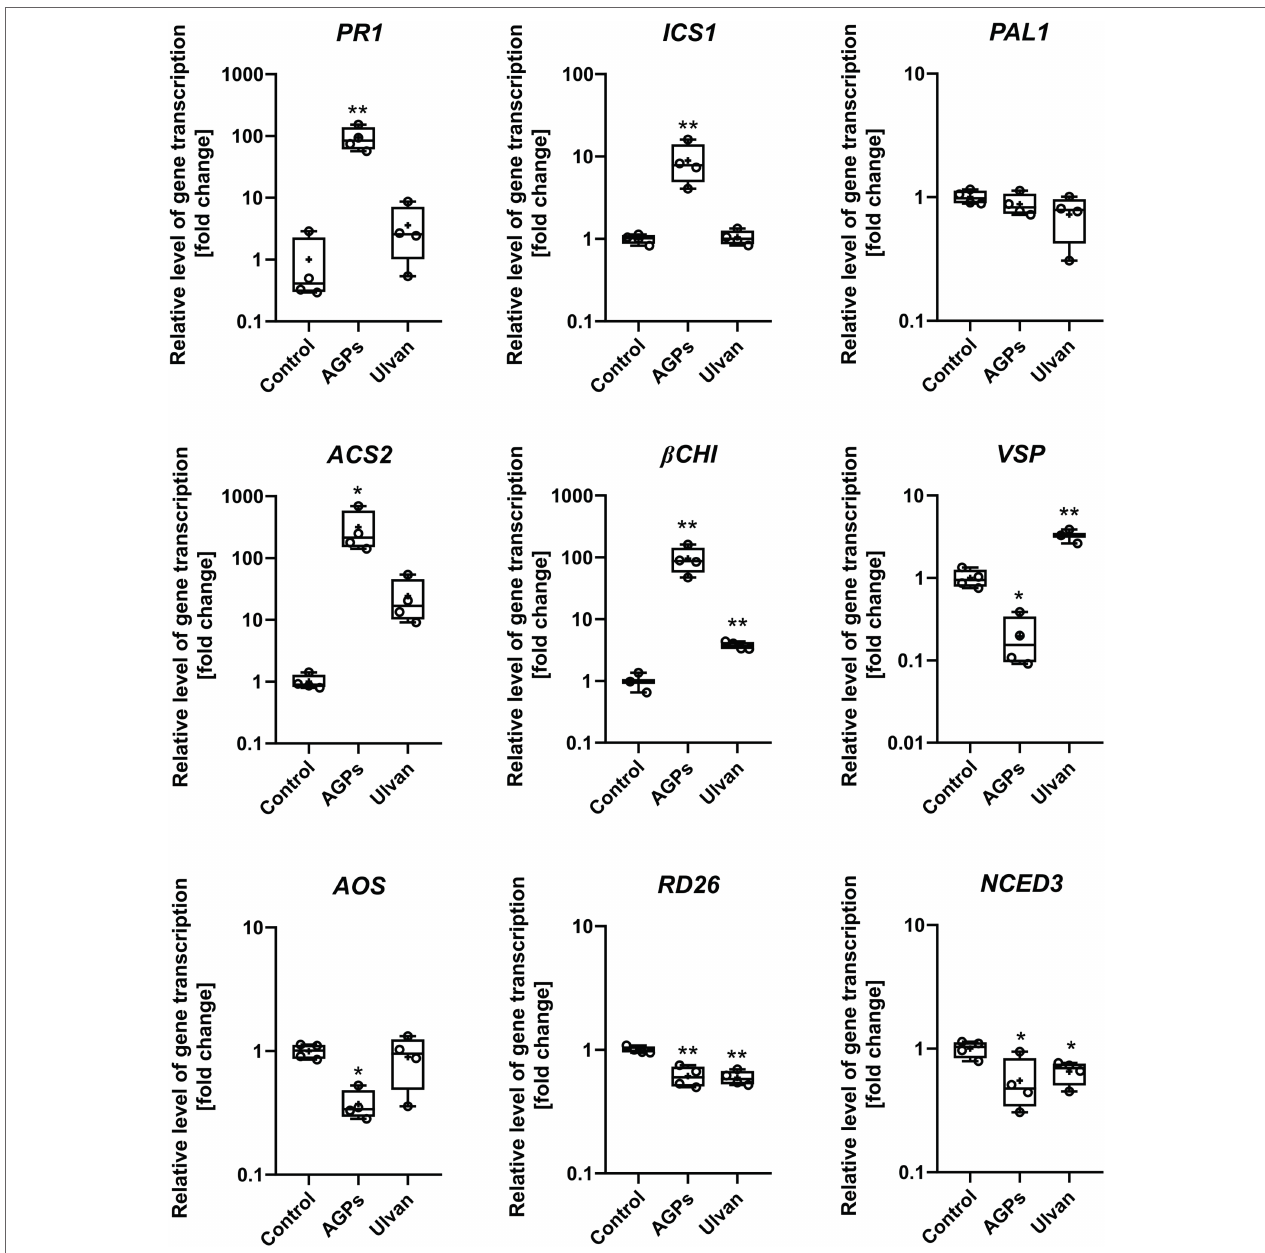
FIGURE 5 | Effect of algal elicitor treatment on activation of plant defense pathways in B. napus cotyledons. Cotyledons were treated with AGP-like enriched fraction (AGPs), ulvan extracted according to Yaich et al. (2013) (Ulvan) and distilled water (Control) by infiltration in 0.1 mg·mL − 1 concentration. After 24 h, gene expressions of marker genes of salicylic acid pathway ( PR1 , ICS1 , and PAL1 ), ethylene pathway ( ACS2 ), ethylene/jasmonic acid pathway ( β CHI ), jasmonic acid ( VSP and AOS ), and abscisic acid ( RD26 , NCED3 ) were analyzed. Data from the representative experiment are shown. Relative expression was calculated with efficiency correction and normalization to actin . Data are plotted at the log 10 scale. Asterisks indicate statistically significant differences from control determined by the t -test * p < 0.05 or ** p <